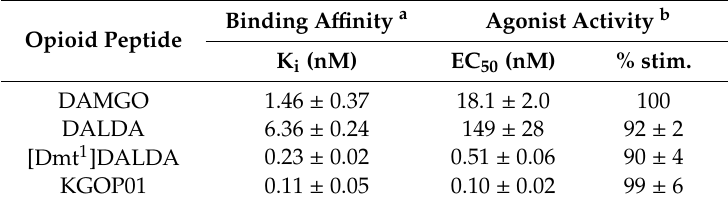
Table 1. In vitro binding and agonist activity of opioid peptide analogues at the human MOR. Binding A ffi nity Opioid Peptide